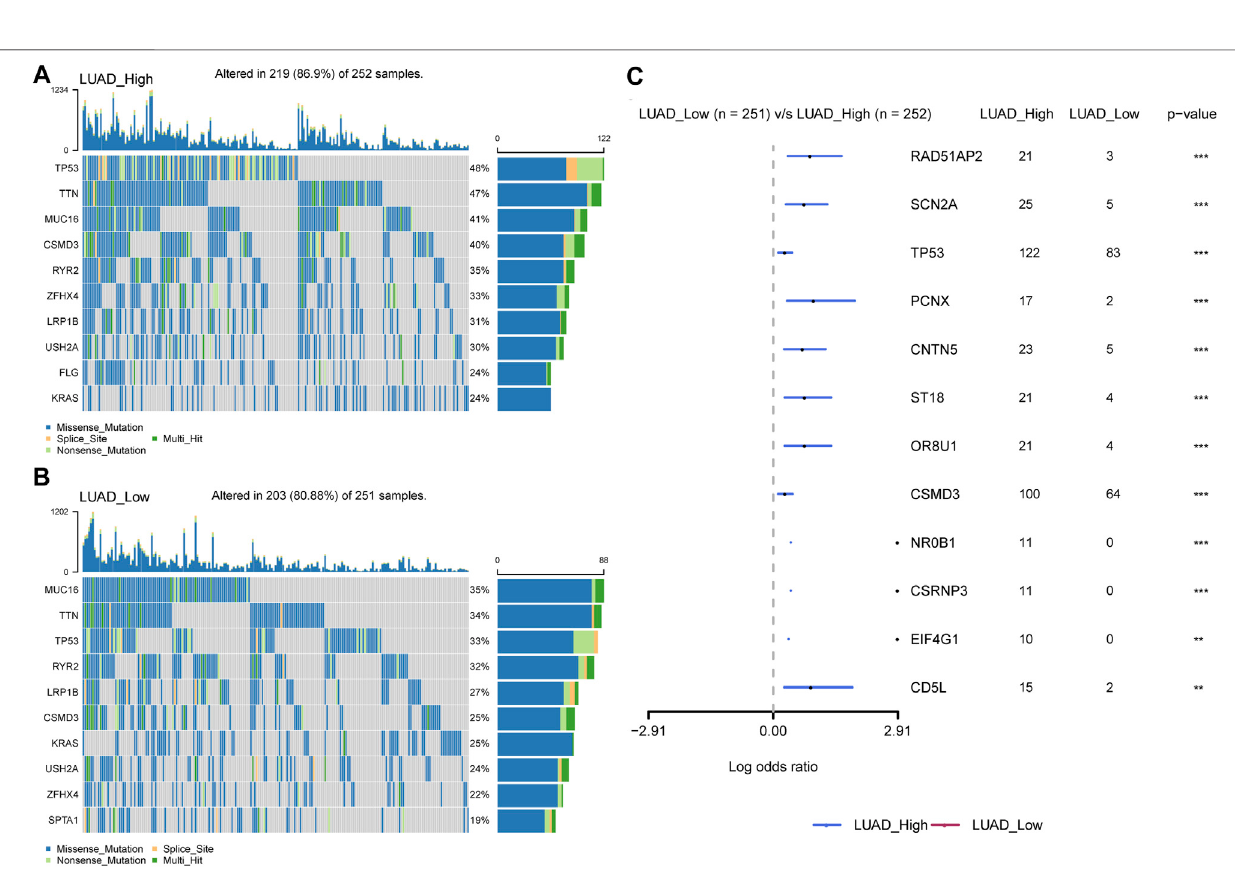
FIGURE 12 | Gene mutation between high and low-P4HA1 groups in LUAD. (A) The top 10 genes with the highest mutation frequency in high-P4HA1 groups calculated by R package “ maftools ” . (B) The top 10 genes with the highest mutation frequency in low-P4HA1 groups. (C) The gene mutation differences between high and low-P4HA1 groups in